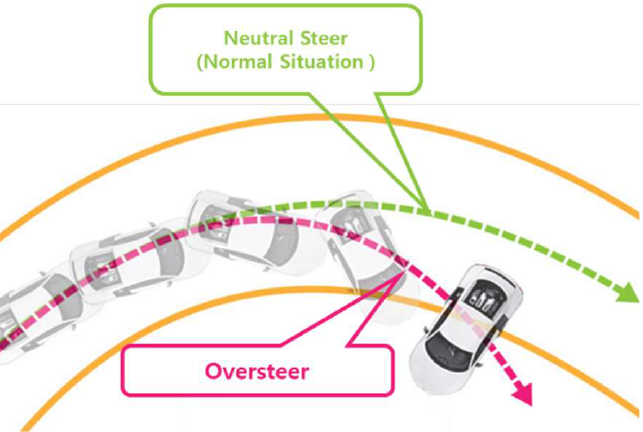
Figure 1. Schematic of the oversteering phenomenon.